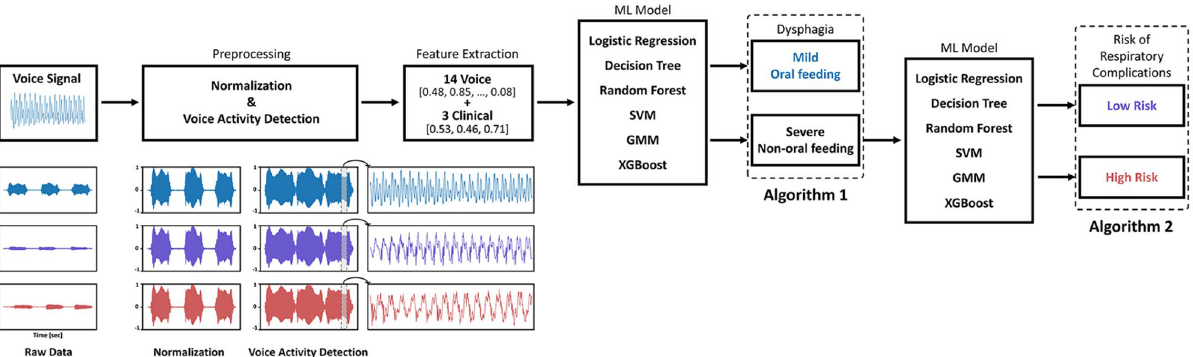
Figure 1. Algorithm development. Raw data from voice signals were preprocessed after normalization. Clinical data were concatenated to the Praat features in the machine learning models. A two step-process was then used to first classify those with oral feeding versus tube feeding (algorithm 1) and, among the latter, classify those at high risk of respiratory complications (algorithm 2). ML machine learning, SVM support vector machine, GMM Gaussian mixture model, XGBoost extreme gradient